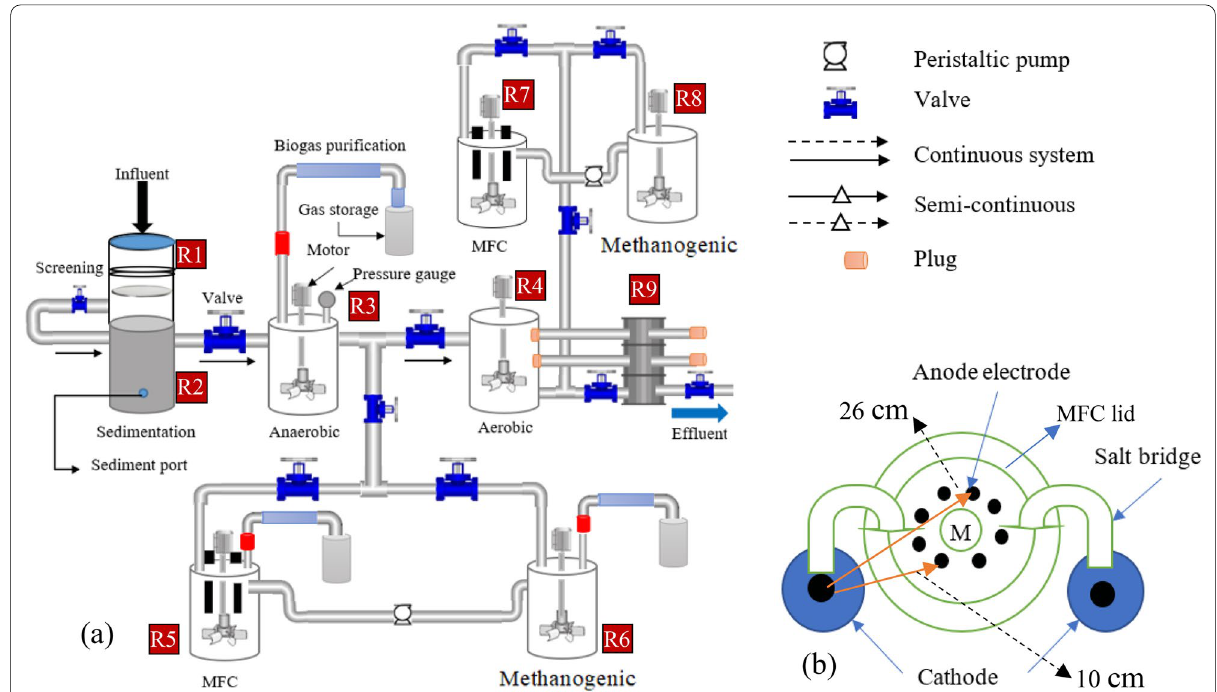
Fig. 1 Schematic diagram of a the integrated aerobic-MFC and anaerobic-MFC system, and b electrode arrangement, not drawn to scale. M motor, R reactor, R1 filtration, R2 sedimentation, R3 anaerobic, R4 aerobic (MBBR), R5 MFC, R6 methanogenic, R7 MFC, R8 methanogenic, and R9 adsorpton column. The cathode section is not shown to simplify the